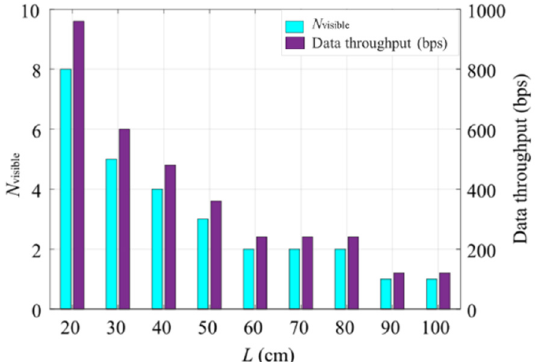
Figure 10. MIMO-OCC performance analysis: the data throughput with respect to N visible Figure 10. MIMO ‐ OCC performance analysis: the data throughput with respect to N visible bits.